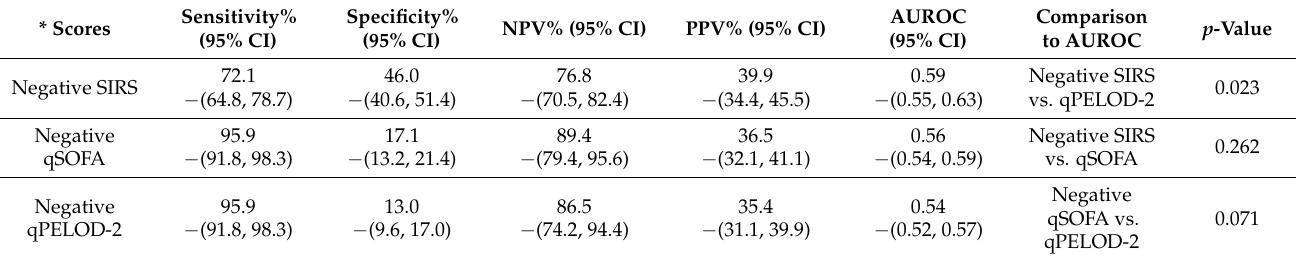
Table 3. Prognostic accuracy of scoring systems (95%CI), area under the curve (95% CI) and comparison to AUROC